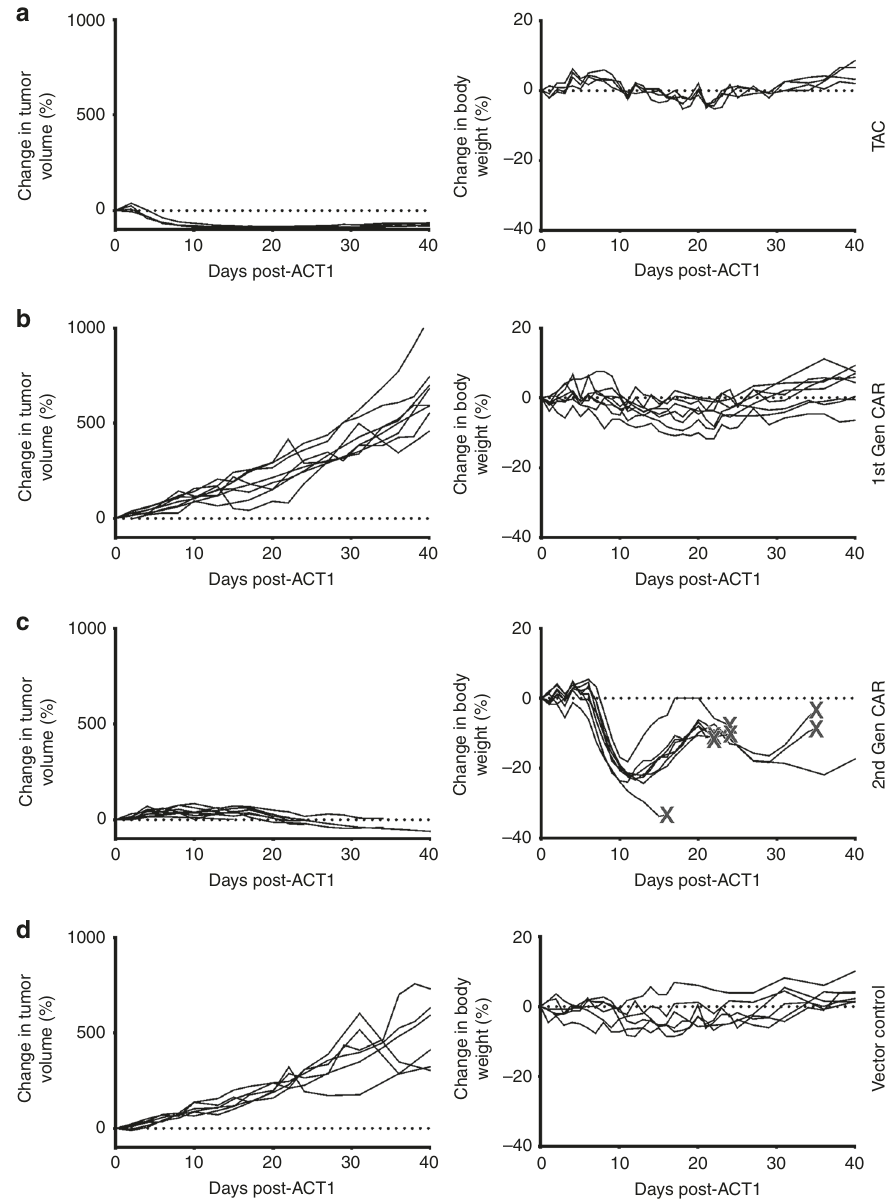
Fig. 5 HER2-TAC-T cells demonstrate an enhanced safety pro fi le and improved ef fi cacy over fi rst- and second-generation HER2-CAR-T cells in vivo. OVCAR-3 tumor-bearing mice are treated with 2.0 × 10 6 HER2-TAC-T cells ( a ), fi rst-generation anti-HER2 CAR-T cells ( b ), second-generation anti-HER2 28 ζ CAR-T cells ( c ), or a matched total number of vector control T cells ( d ). Mice are followed for change in body weight and tumor volume; each curve represents a single treated mouse relative to pre-treatment weight/volume. When mice reach endpoint, this is indicated via X in ( c ). Data has been replicated in an independent experiment. Using curve fi tting analysis and multiple t -test HER2-TAC induced regression is signi fi cantly different from control, 1st, and 2nd generation CAR curves, while tumor growth between vector control and 1st gen CAR was not signi fi cantly different. The change in body weight observed in 2nd gen CAR curves is signi fi cantly different from vector control, 1st gen CAR, and TAC-T cell treated mice. However, the difference in body weight between vector control, 1st gen CAR, and TAC curves was not signi fi cantly